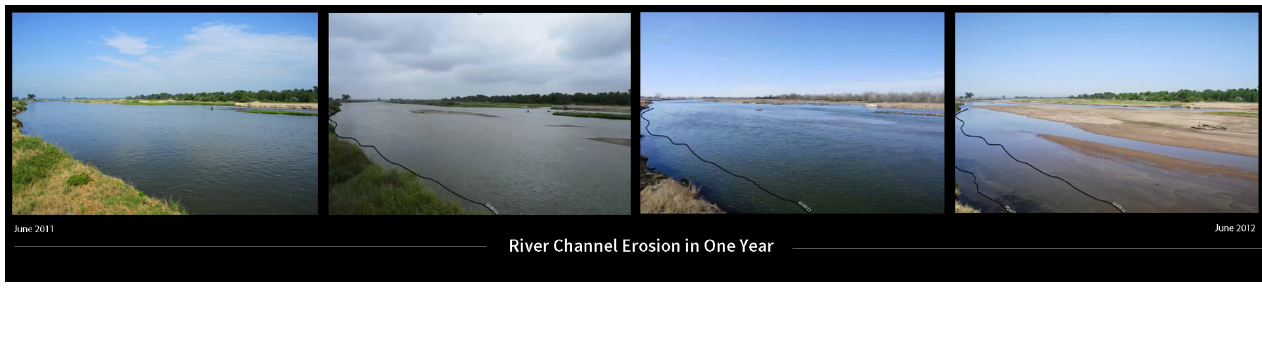
Fig. 7 . Time-lapse imagery illustrating river morphology and erosion of the Platte River stream bank over time at Plum Creek